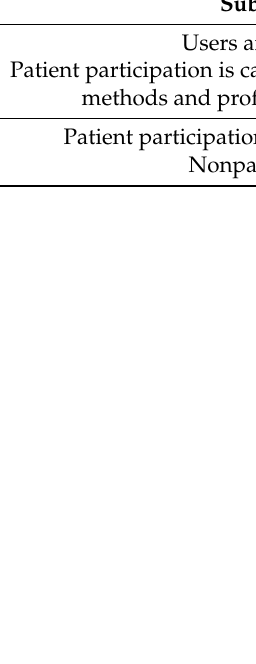
Table 3. Subthemes, themes, and main theme. Subthemes Themes Main Theme Users are included. Patient participation is not conditions.Patient participation is carried out based on structural a free choice. Patient participation is based on methods and professional expectations. structural Patient participation is an individual thing. Patient participation is a